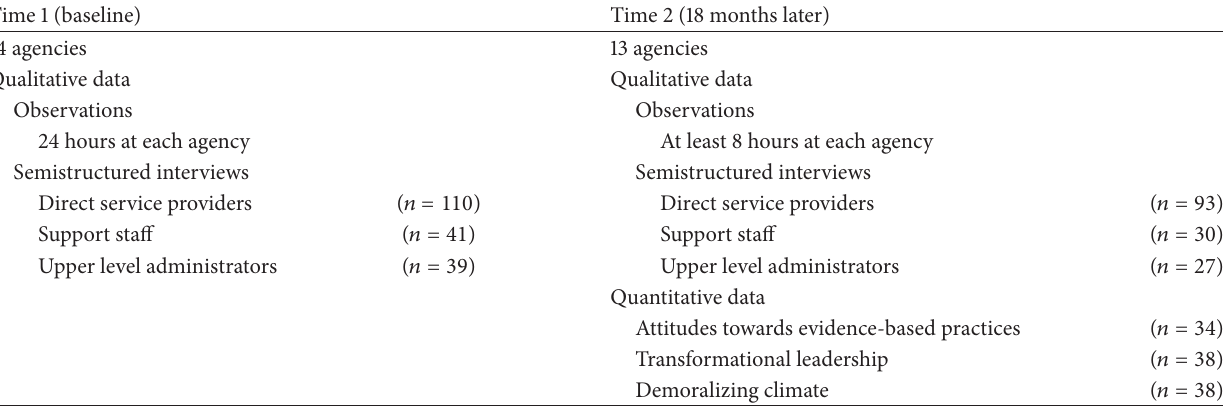
Table 2: Sequence of data collection.